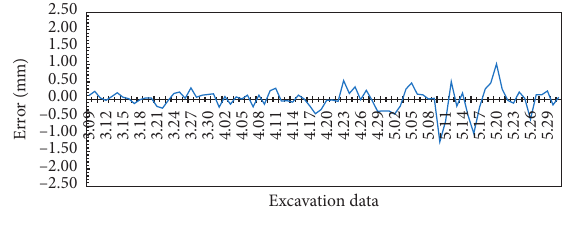
Figure 10: Prediction error in the uplift deformation of tunnel section